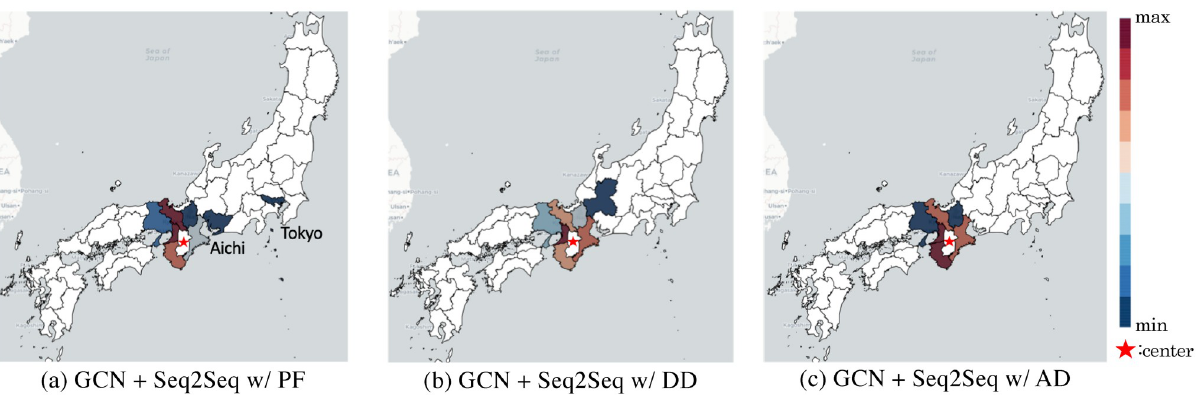
Fig 3. Visualization of the weights of learned localized filters of Eq (2) for (a) GCN+Seq2seq w/ PF, (b) GCN+Seq2seq w/ DD, and (c) GCN +Seq2seq w/ AD against the prediction target node (Nara prefecture, as shown by a star). The colors represent the weights, i.e., strength of influence of each prefecture on the prediction of the target prefecture. The red prefectures are given assigned larger weights, i.e., they contribute significantly for to predicting the epidemics of in the target prefecture, while blue prefectures are given assigned smaller weights. Note that most prefectures are represented in white for visibility, as their weights are less than 5% of the maximum.